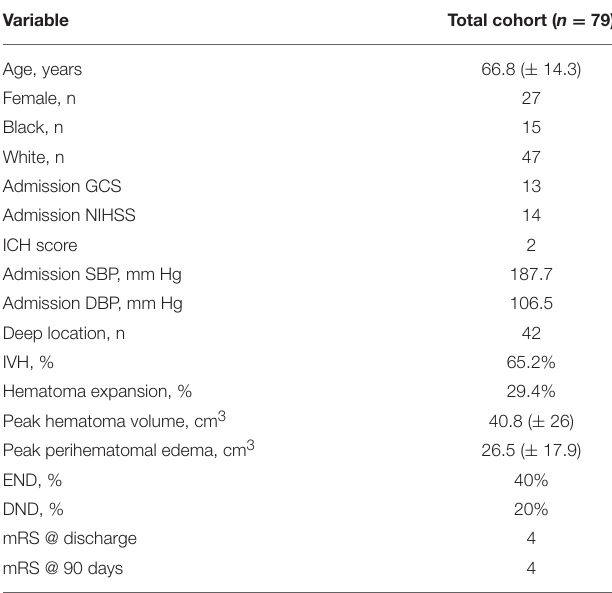
TABLE 1 | Baseline patient demographics and ICH